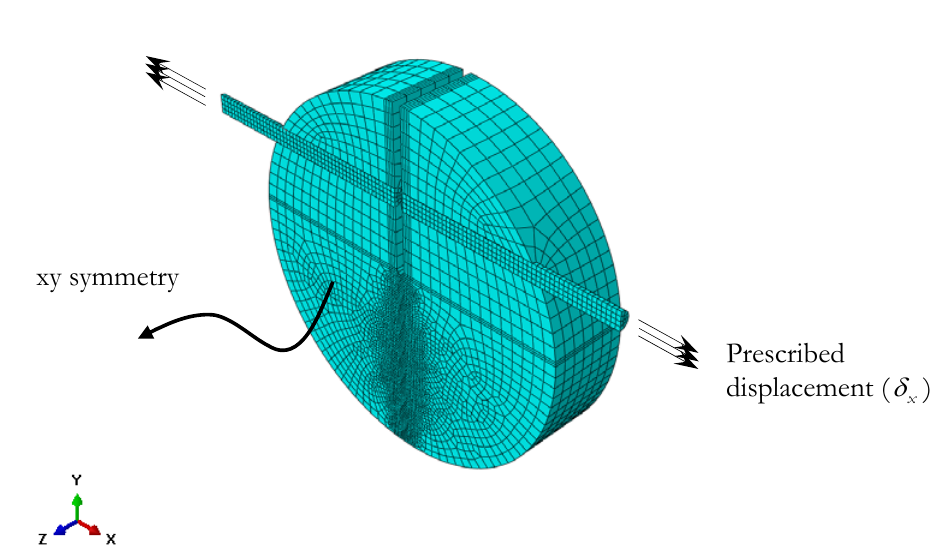
Figure 6: Mesh and boundary conditions for model 3.